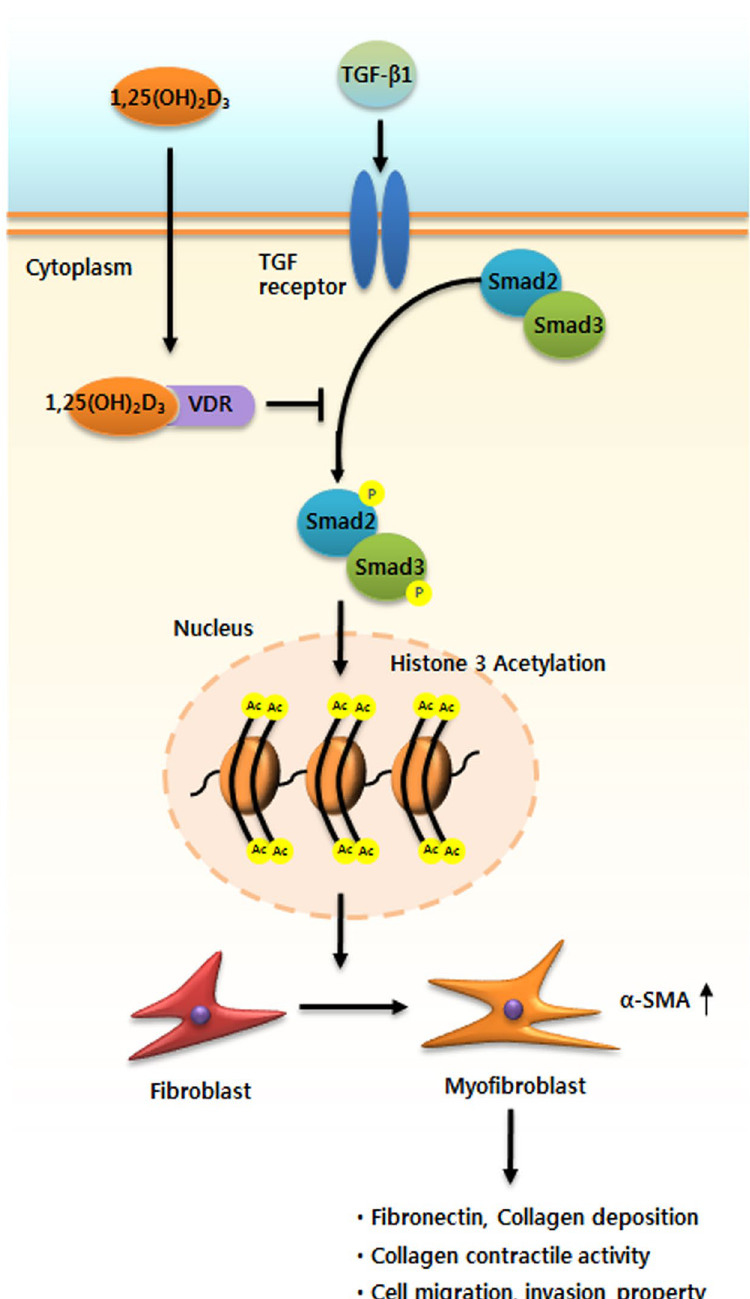
Figure 7. Role of 1,25(OH) 2 D 3 in myofibroblast differentiation and extracellular matrix deposition in TGF- β 1- induced nasal polyp-derived fibroblasts and nasal ex vivo organ culture. 1,25(OH)2D3 suppressed myofibroblast differentiation and extracellular matrix production by reducing acetylation of histone 3 through inactivation of the Smad2/3 signaling pathway associated with vitamin D receptors, resulting in prevention of collagen contractile activity and cell migration in the upper airway under TGF- β 1